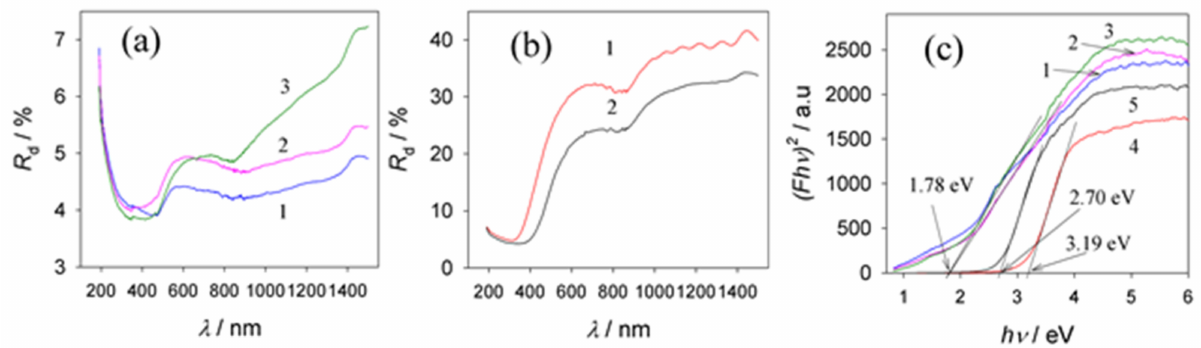
Figure 8. Diffuse reflectance spectra ( a ) and corresponding Tauc plots for possible direct transitions ( c ) in the composite films fabricated by Al anodization in a solution containing 0.2 mol · L − 1 NaVO 3 and 0.8 mol · L − 1 HCOOH (pH 2.67) at bath voltages of 60 (1), 80 V (2), and 100 V (3) for 1 h. ( b ) As in ( a ) for Al anodization at 80 V for 2 (1) and 5 (2) min. ( c ) Tauc plots for possible direct transitions in the composite films fabricated by Al anodization in the same solution at bath voltages of 60 (1), 80 (2), and 100 V (3) for 1 h, and at 80 V for 2 (4) and 5 min